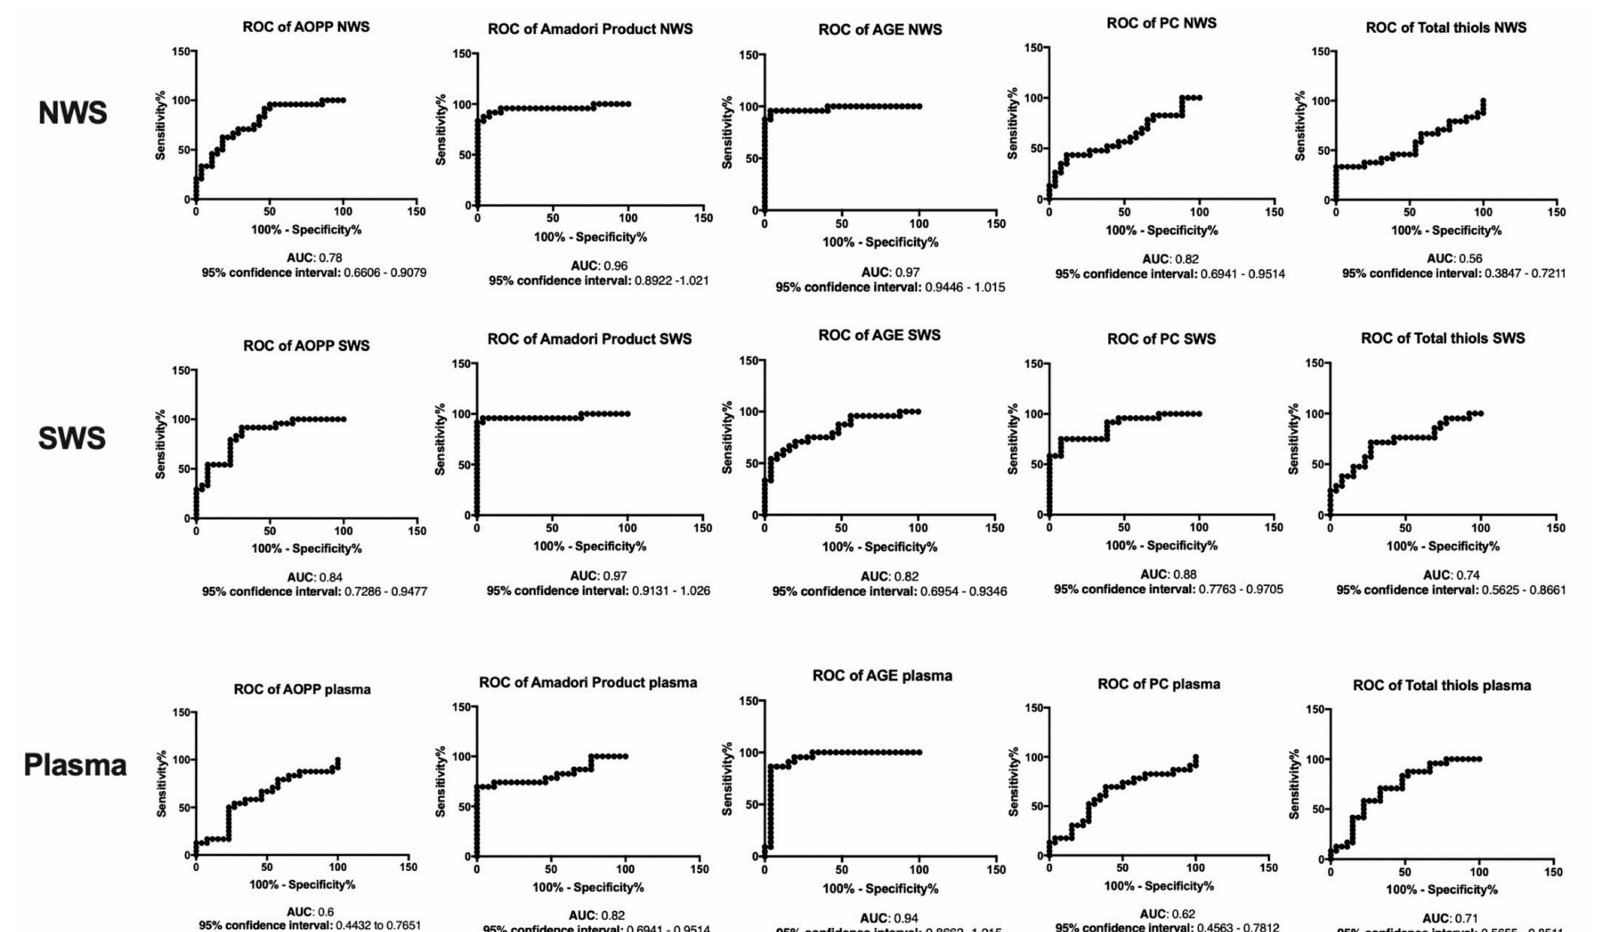
Figure 7. Receiver operating characteristic (ROC) analysis of oxidative damage products in non-stimulated and stimulated saliva as well as plasma of patients in di ff erent stages of dementia. Abbreviations: AGE—advanced glycation end products; AOPP—advanced oxidation protein products; AUC—area under the curve; NWS—non-stimulated whole saliva; PC—protein carbonyls; SWS—stimulated whole